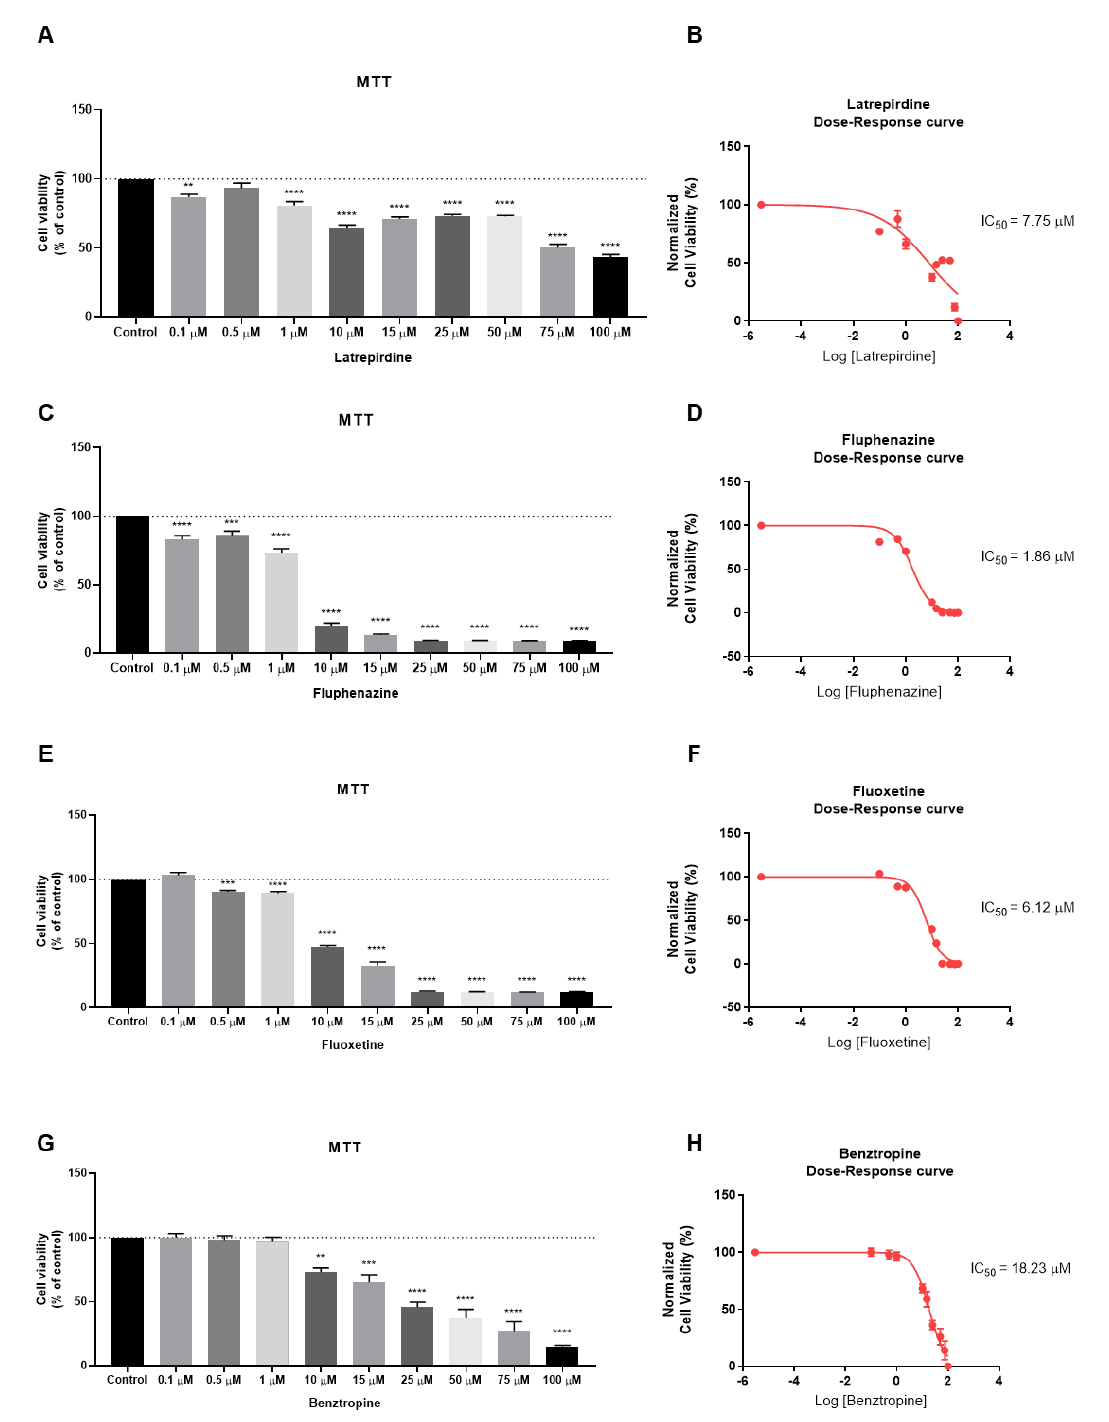
Figure 2. The effects of some CNS drugs on HT-29 cells. ( A ) The effect of latrepirdine on cell viability and ( B ) the dose- response curve. ( C ) The effect of fluphenazine on cell viability and ( D ) the dose-response curve. ( E ) The effect of fluoxetine on cell viability and ( F ) the dose-response curve. ( G ) The effect of benztropine on cell viability and ( H ) the dose-response curve. Cells were cultured in the presence of increasing concentrations of each drug, and after 48 h, the MTT assay was performed to measure the cellular viability. Values are expressed in percentage of control and represent means ± SEM. Each experiment was done three times independently ( n = 3); ** statistically significant vs. control at p < 0.01. *** statistically significant vs. control at p < 0.001. **** statistically significant vs. control at p <